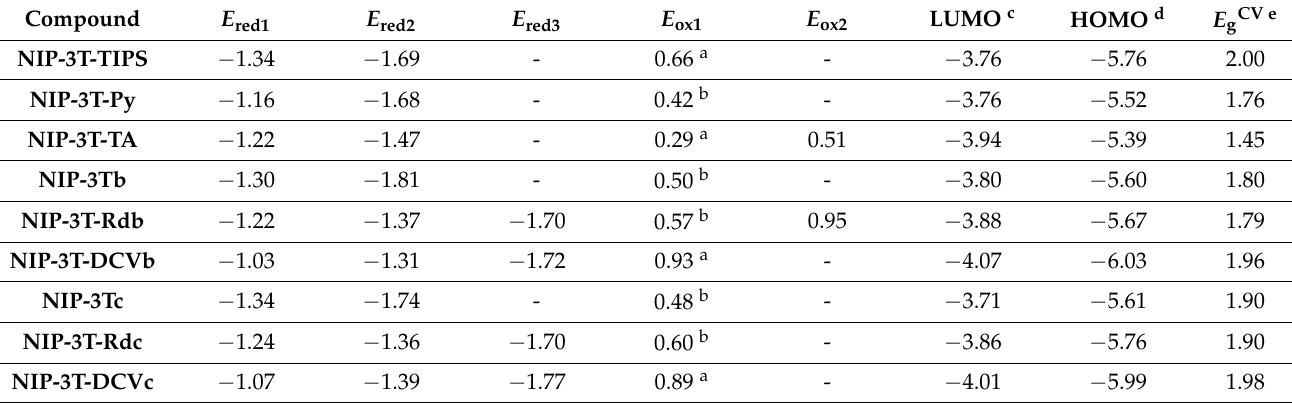
Table 10. Electrochemical potentials versus SCE in CH 2 Cl 2 (referenced to Fc/Fc + couple) of functionalized NIP-3T derivatives and frontier molecular orbital energies estimated from CV